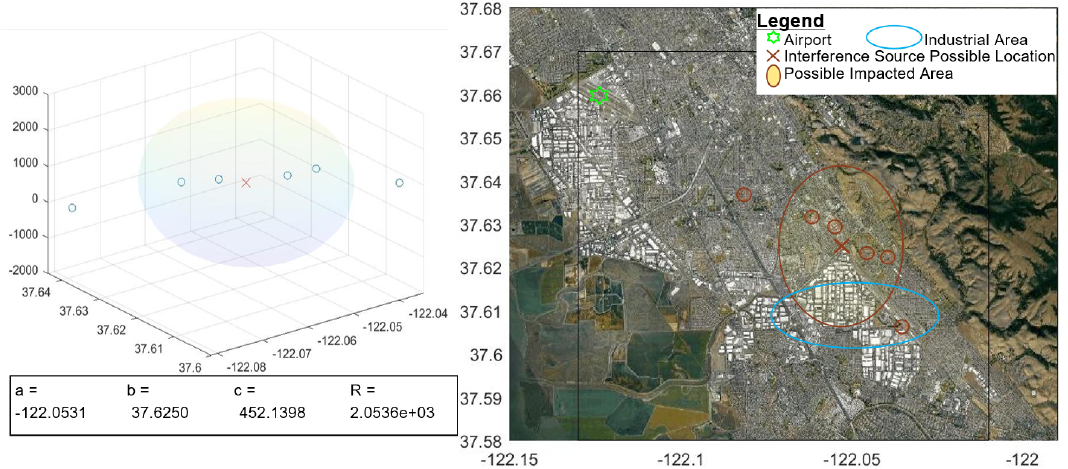
Figure 12. Result from real data: on 3D plot ( left ); and on Google Earth map ( right